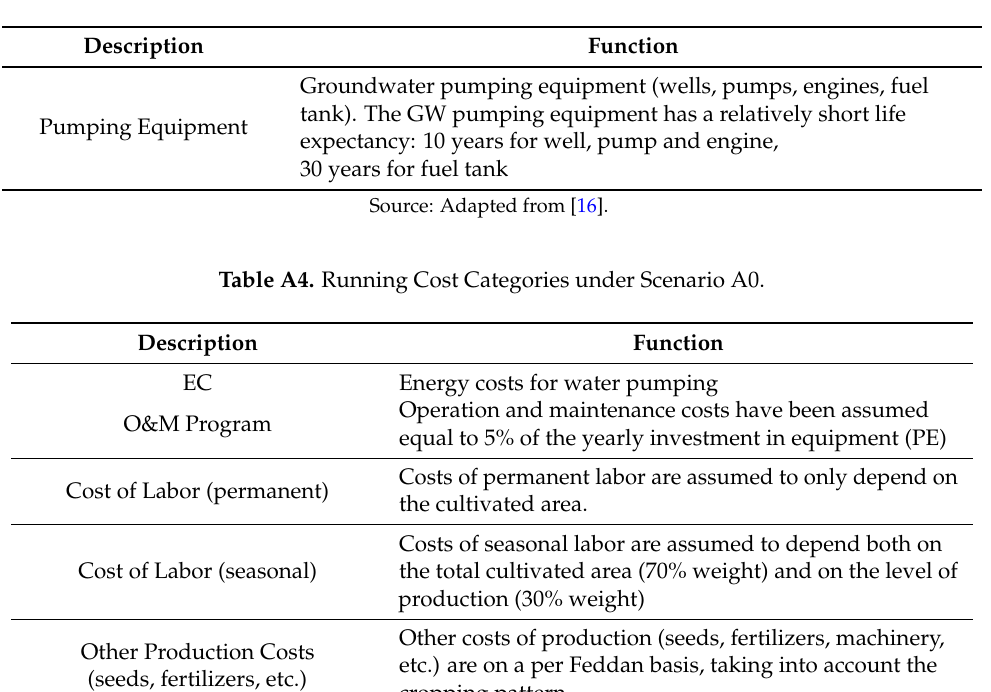
Table A3. Investment Cost Categories under Scenario A0.